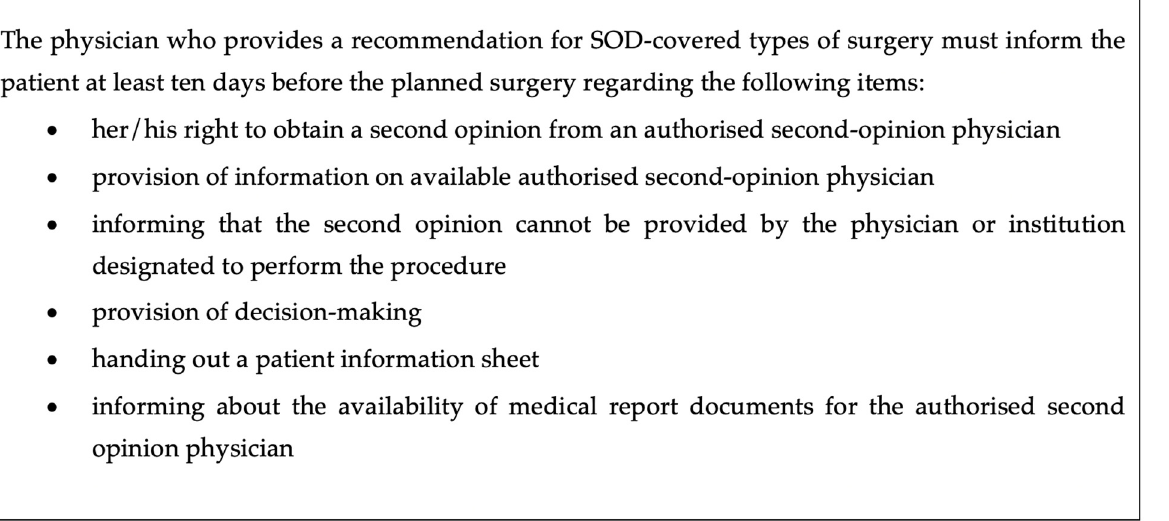
Figure 2. Mandatory Information obligations for the physician who first suggests surgery according to the 2018 Second Opinion Directive (SOD); decision-making aids are available at: https://www.iqwig.de/presse/pressemitteilungen/pressemitteilungen-detailseite_10140.html (assessed on 3 March 2022).